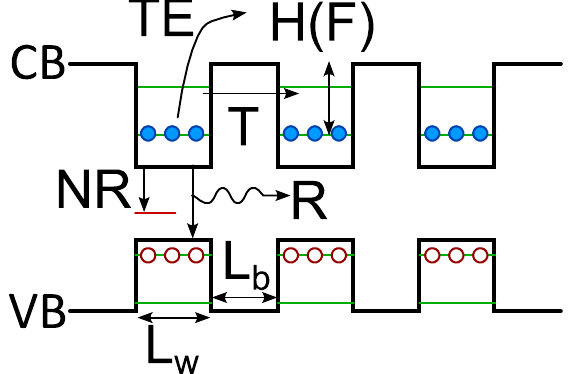
Figure 8. Simplified representation of the band structure (with flat bands) of the device. The bending due to polarization fields is not shown for simplicity. L w is the well thickness, L b is the barrier thickness, H(F) is the effective barrier height (electric field dependent), related to the band structure inside the wells and their occupation.